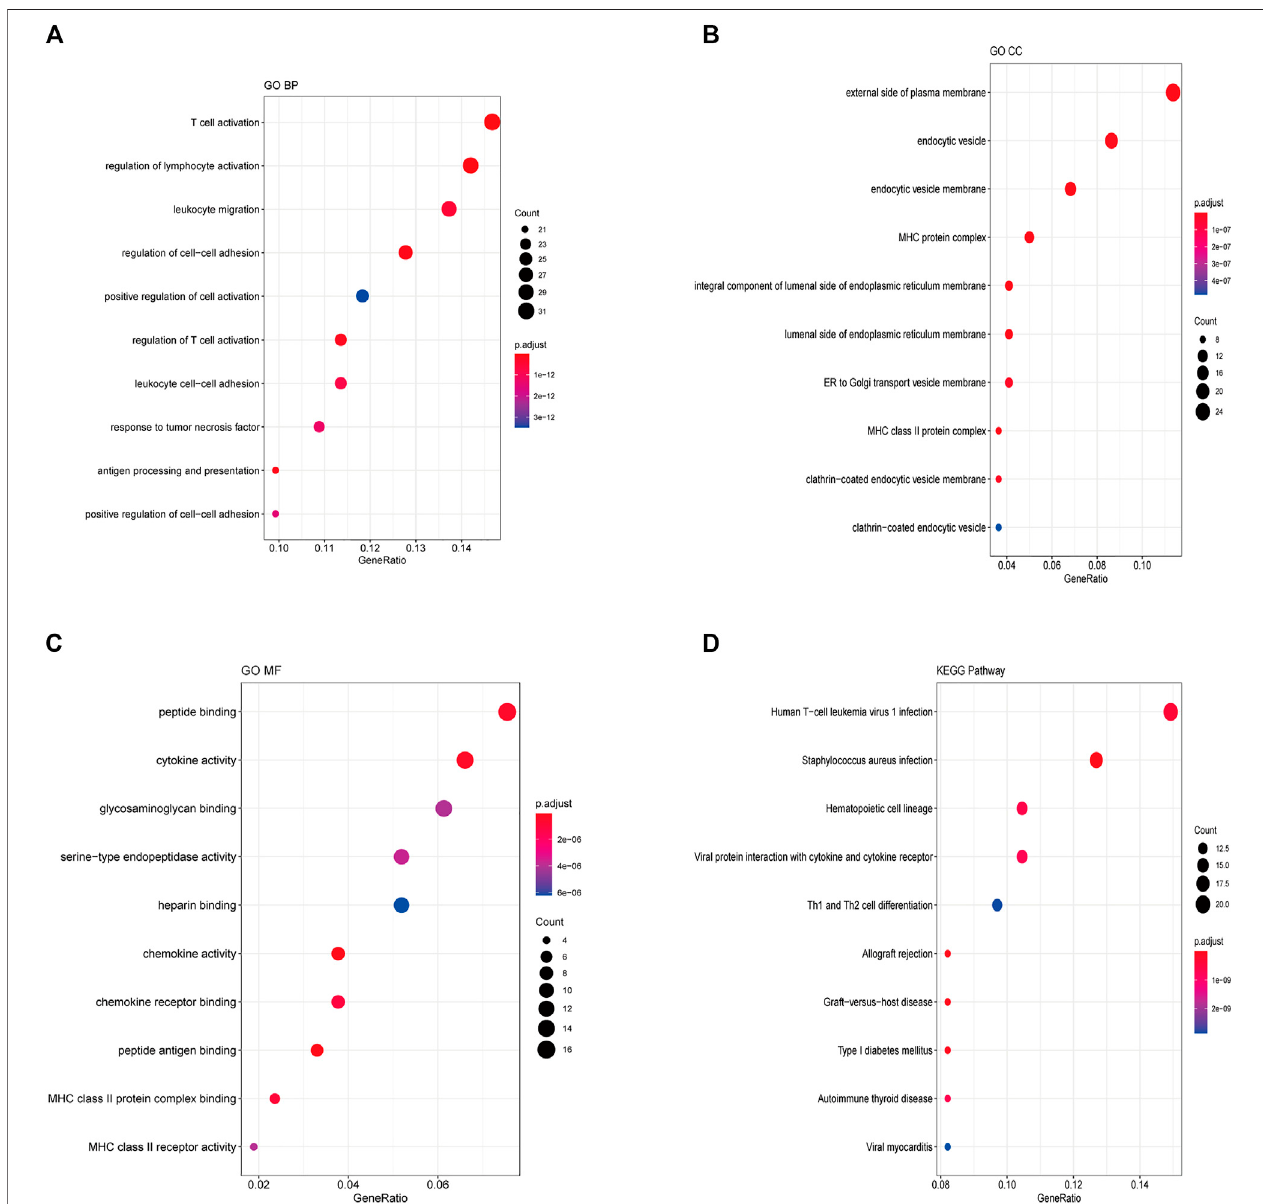
FIGURE5| Functional annotationofstemness-index-related lncRNA signature. GO-Biological processes (A) ,GO-Cellular component (B) ,GO-Molecular function (C) , and KEGG pathway enrichment analysis (D) . Immune cell in fi ltration between high- and low-risk groups (E) . GO, Gene Ontology; KEGG, Kyoto Encyclopedia of Genes and